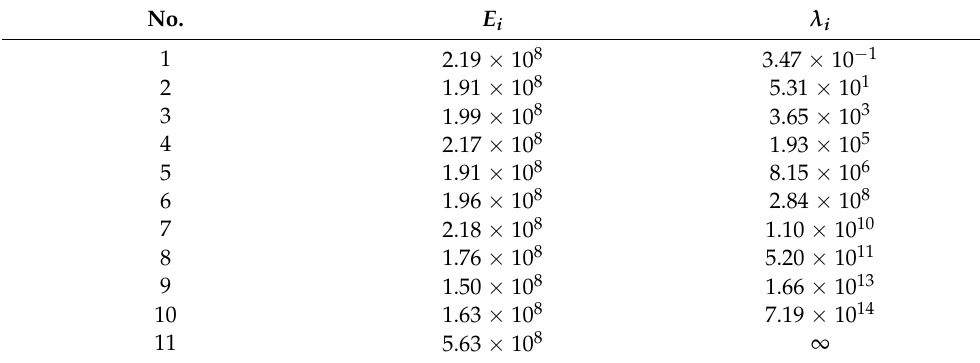
Table 6. E i and λ i for Polymer C.